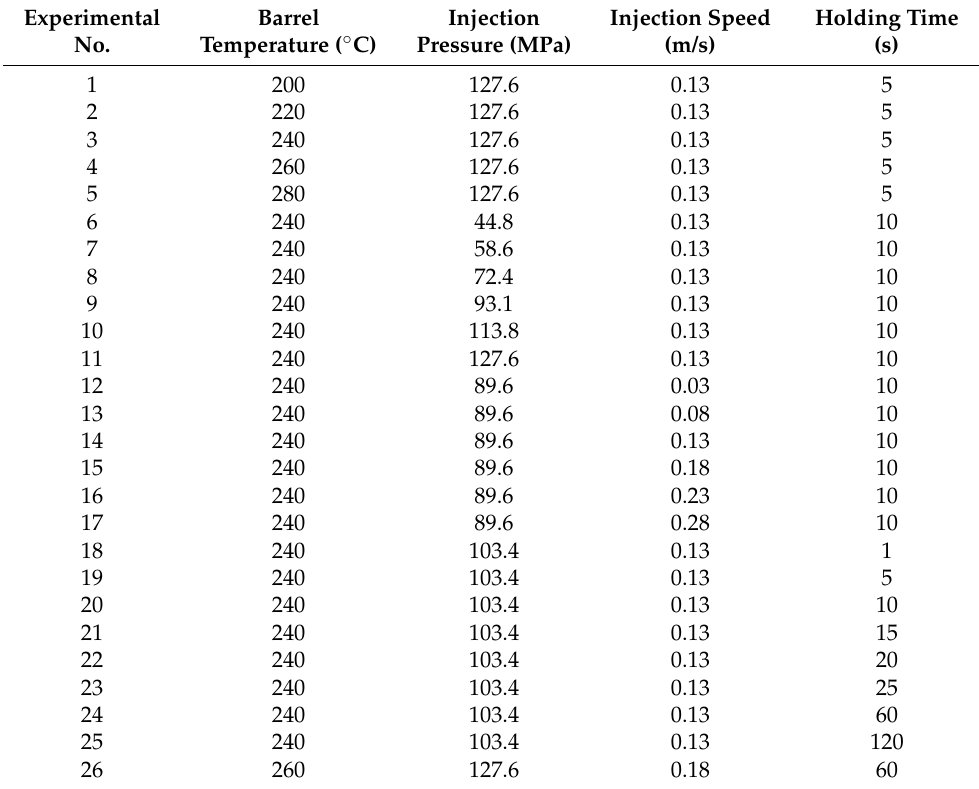
Table 2. Injection molding parameters for the preparation of the PP SPC samples.